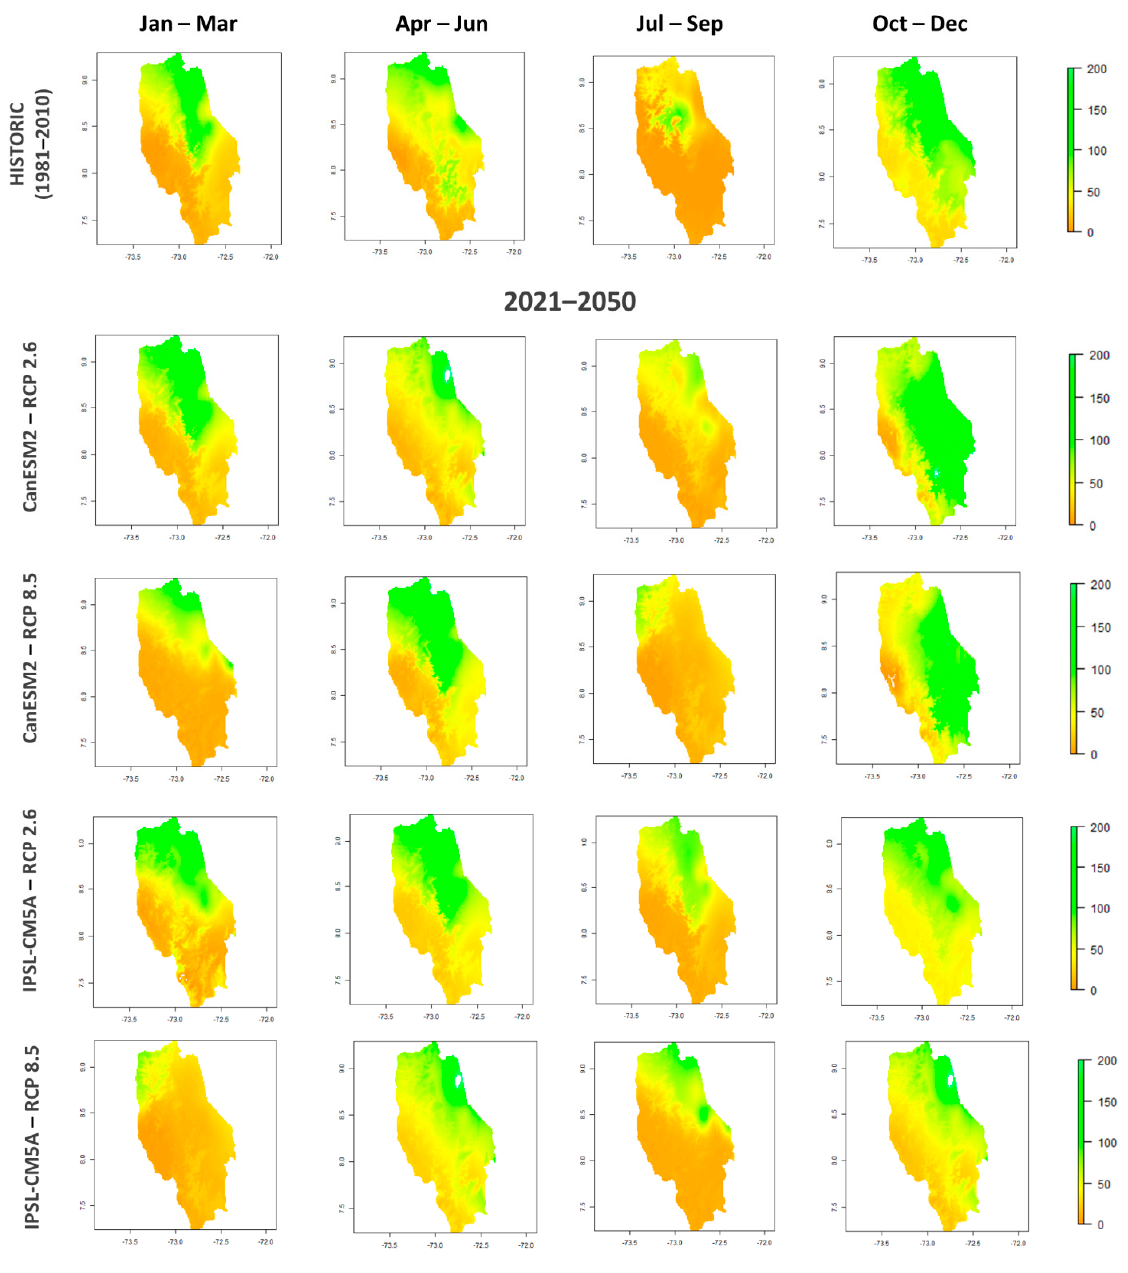
Figure A5. Stream Flow Figure B1. Stream Flow 2021–2050